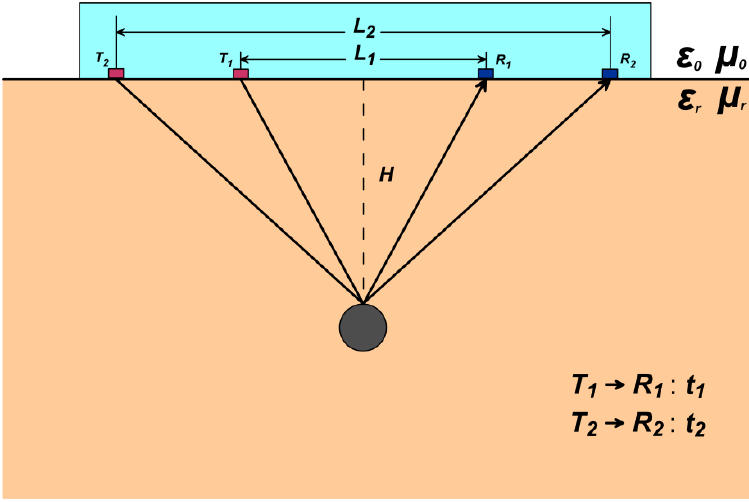
Figure 1. Schematic diagram of the first case (there is no space between the radar and the